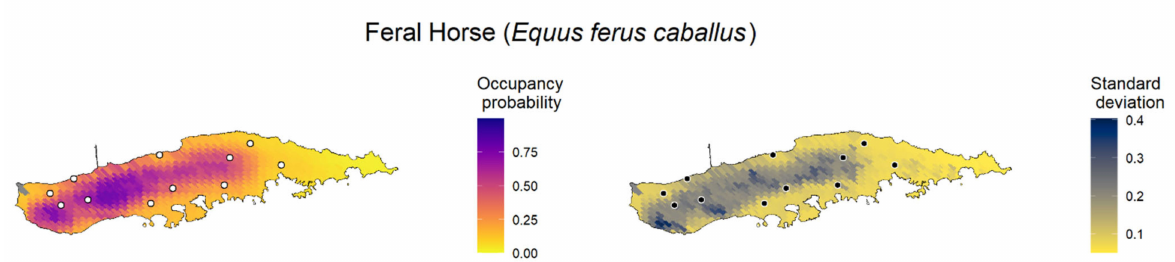
Figure A18. Prediction maps using the top-ranked model (mean expected occupancy probability) with the model prediction uncertainty (standard deviation) for the invasive alien species found during passive acoustic monitoring across Puerto Rico. When the top-ranked model of the species was the null model for occupancy or did not converge well, we used the model that ranked second-best to draw the prediction maps (i.e., for Molothrus bonariensis , Osteopilus septentrionalis , Rhinella marina , and Capra hircus ), and as such, we highlight that these predictions should be interpreted with caution because there was a high uncertainty associated with them. The circles represent the sampling sites where the species were detected by the AudioMoth devices. The prediction for wild goat was made for Mona Island, the prediction for feral horse was made for Vieques island, and the predictions for the other species were made for the main island of Puerto Rico.